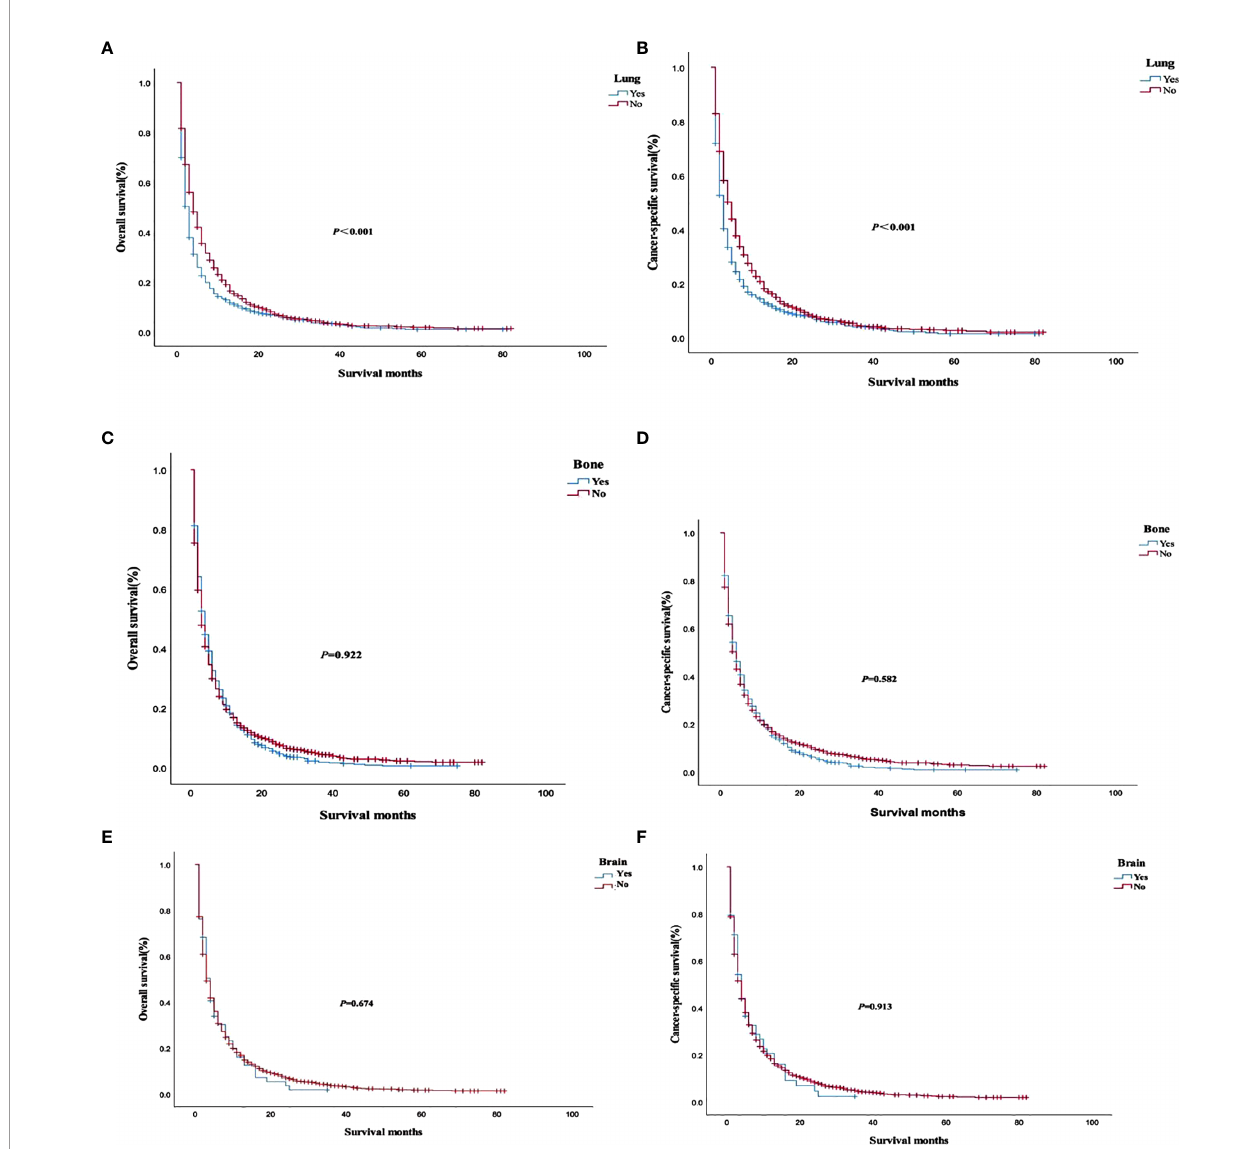
FIGURE 2 | Overall survival and cancer-speci fi c survival curves with or without corresponding organ metastasis. (A, B) lung metastasis; (C, D) bone metastasis; (E, F) brain